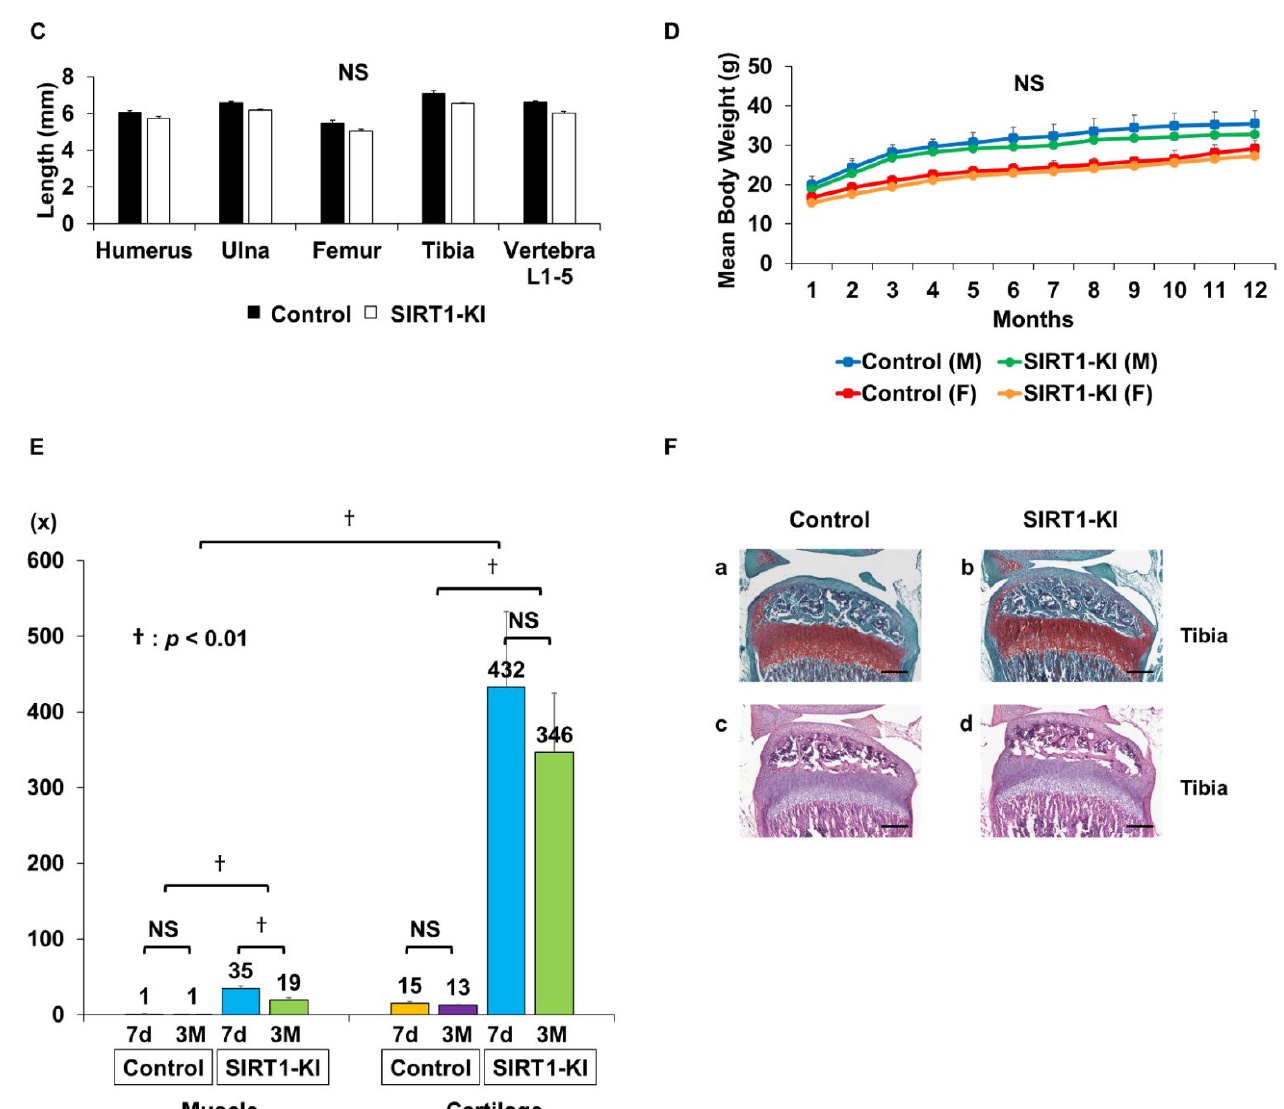
Figure 1. ( A ) Reverse transcription PCR. Genotyping was performed as follows: 257 bp for SIRT1-KI type; and 547 bp for wild type. ( B ) Double-staining with Alizarin red and Alcian blue of the whole skeleton of postnatal day 2 control and SIRT1-KI mice (scale bars = 5 mm). ( C ) Length of long bones and vertebra (first to fifth lumbar spines) of control ( n = 5) and SIRT1-KI ( n = 5) littermate embryos at postnatal day 2. NS, not significant. ( D ) Mean Body Weight (g) of Mice in the Control, SIRT1-KI at the Indicated Time Points ( n = 5 mice/group). NS, not significant. M, male. F, female. ( E ) Sirt1 expression in control mice and SIRT1-KI mice. Relative expression level of Sirt1 mRNA was examined by real-time PCR setting the expression level in the muscle of control mice as 1 ( F ) ( a , b ) Safranin O-fast green staining of the medial knee joint at 3-week-old. Scale bars = 100 µ m. ( c , d ) Hematoxylin-eosin staining of the medial knee joint at 3-week-old. Scale bars = 100 µ